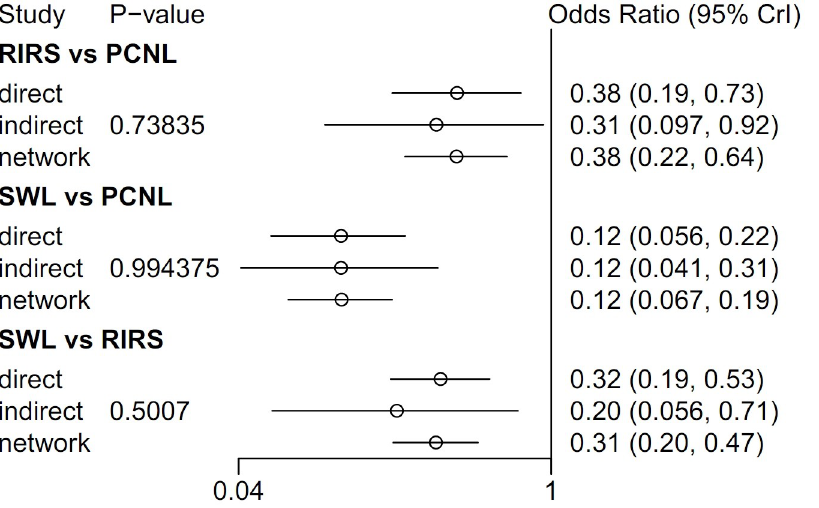
Fig 8. Network meta-analysis for success rate of RIRS, PCNL, SWL, and node-splitting analyses of inconsistency. In node-splitting analysis, no inconsistency was demonstrated in direct, indirect, or network comparison.